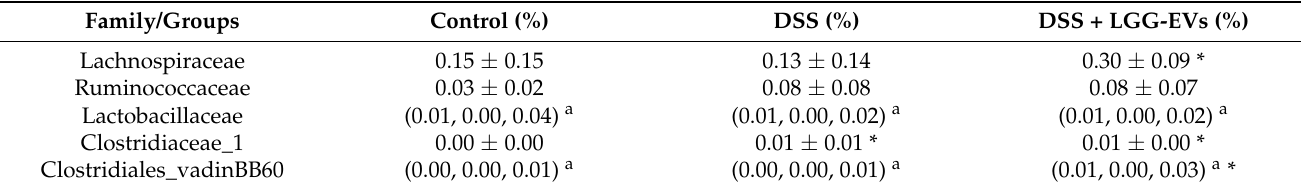
Table 6. Relative abundance of bacteria of classical producer for short-chain fatty acids at the family level ( n = 5). Family/Groups